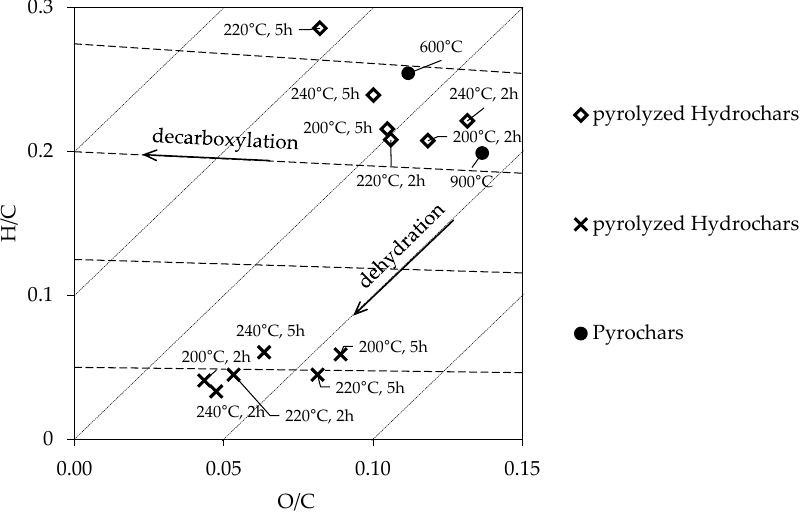
Figure 2. Van Krevelen diagram of pyrochars and pyrolyzed hydrochars.